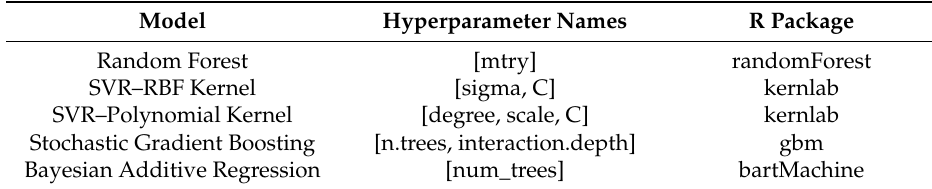
Table 3. The machine learning (ML) models, hyperparameter names, and corresponding optimized values after cross-validated training (the last column includes R packages used for di ff erent ML